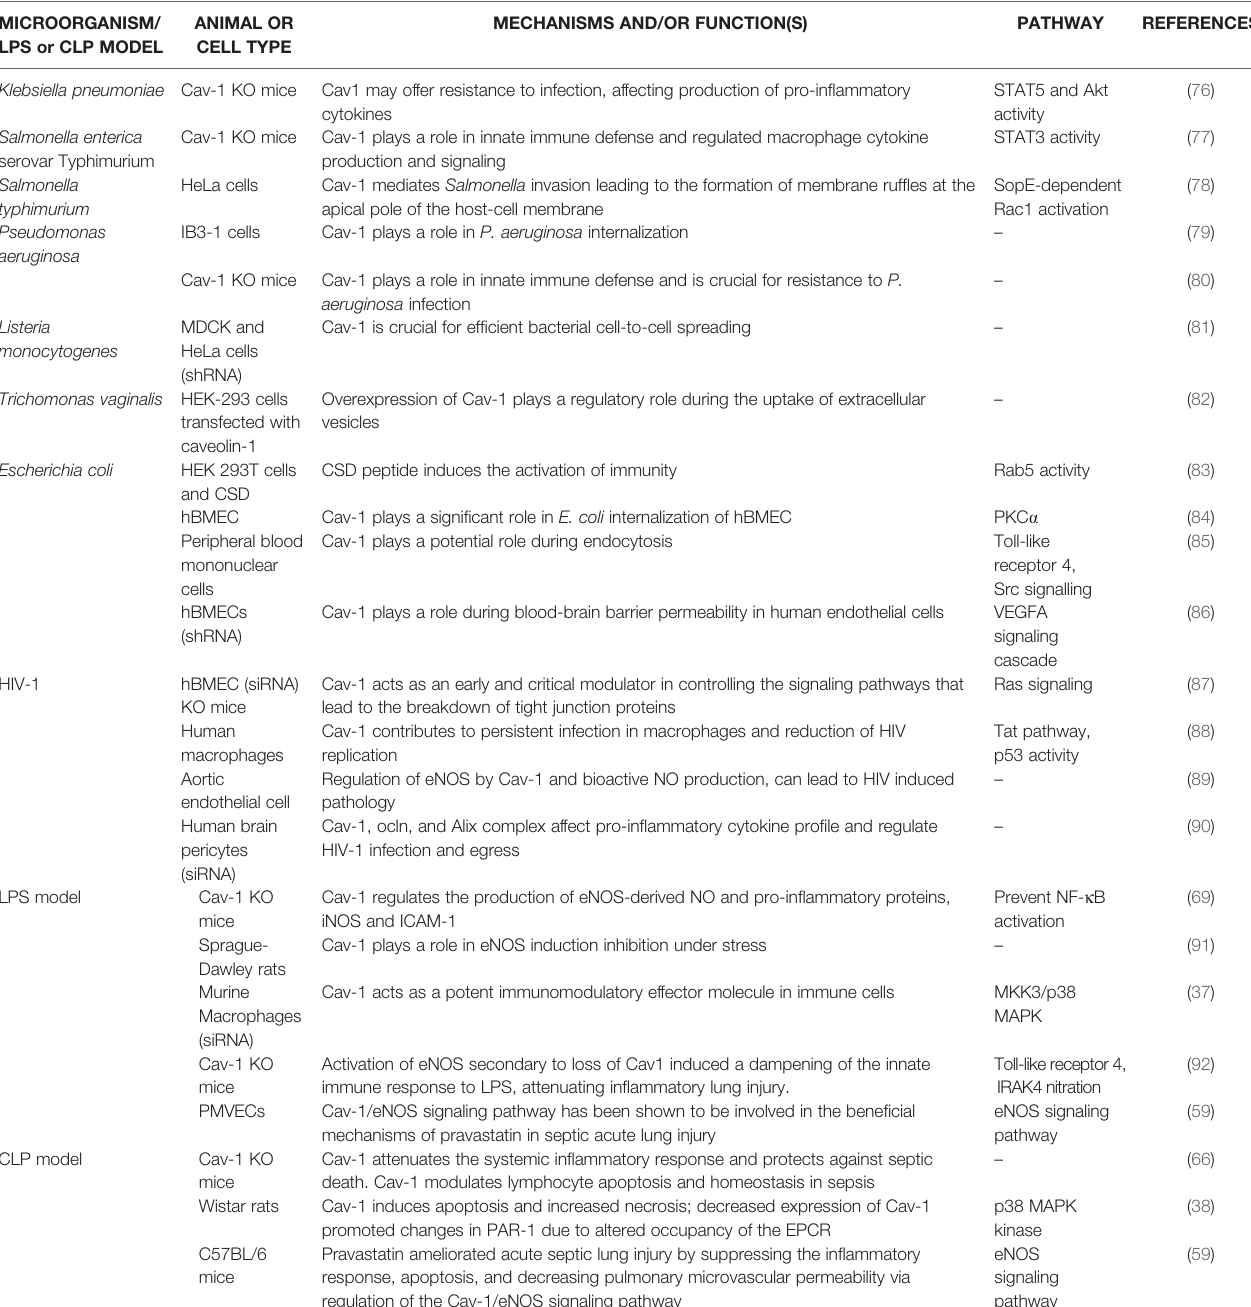
TABLE 1 | Role of Cav-1 during sepsis by